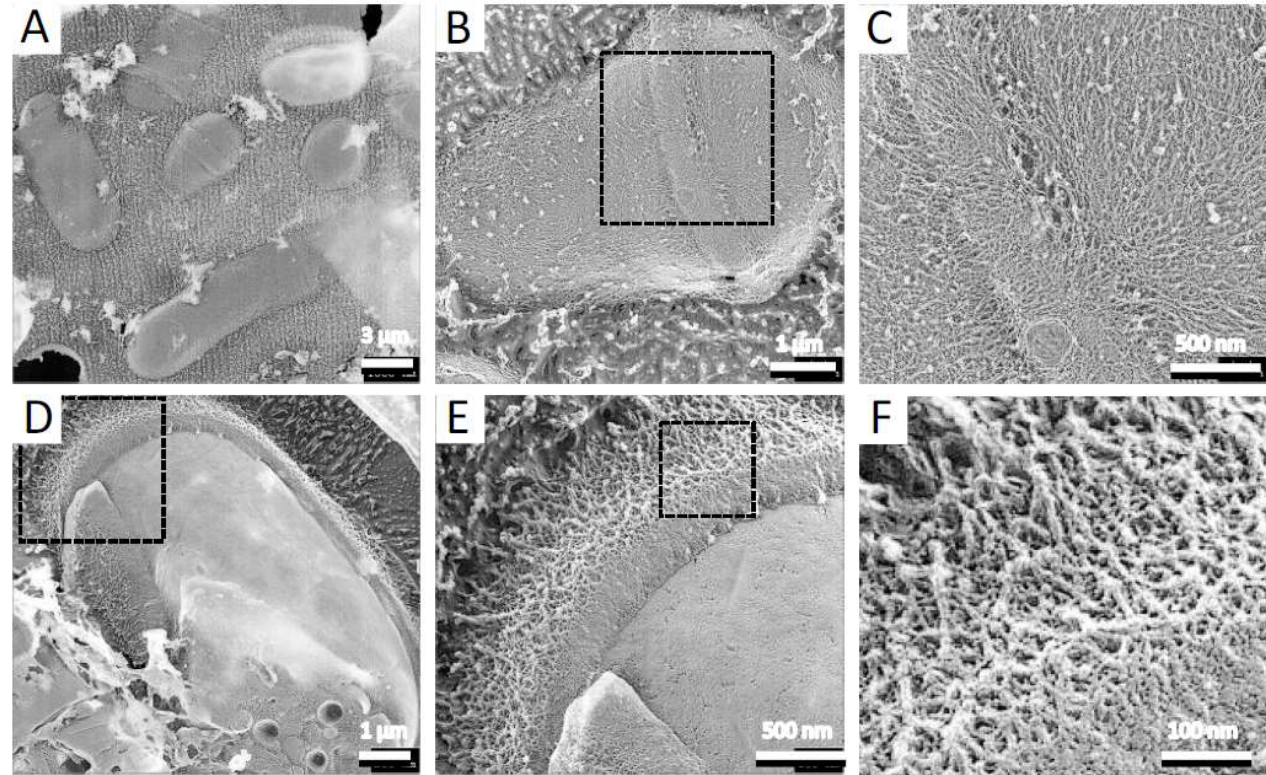
Figure 2. Surface structure of vegetative cell. ( A ) Field image of S. pombe wild-type vegetative cells. ( B ) Single vegetative cell. ( C ) Magnified image of the boxed region in B. ( D ) Single fractured cell. ( E ) Magnified image of the boxed region in ( D ). ( F ) Magnified image of the boxed region in ( E ).